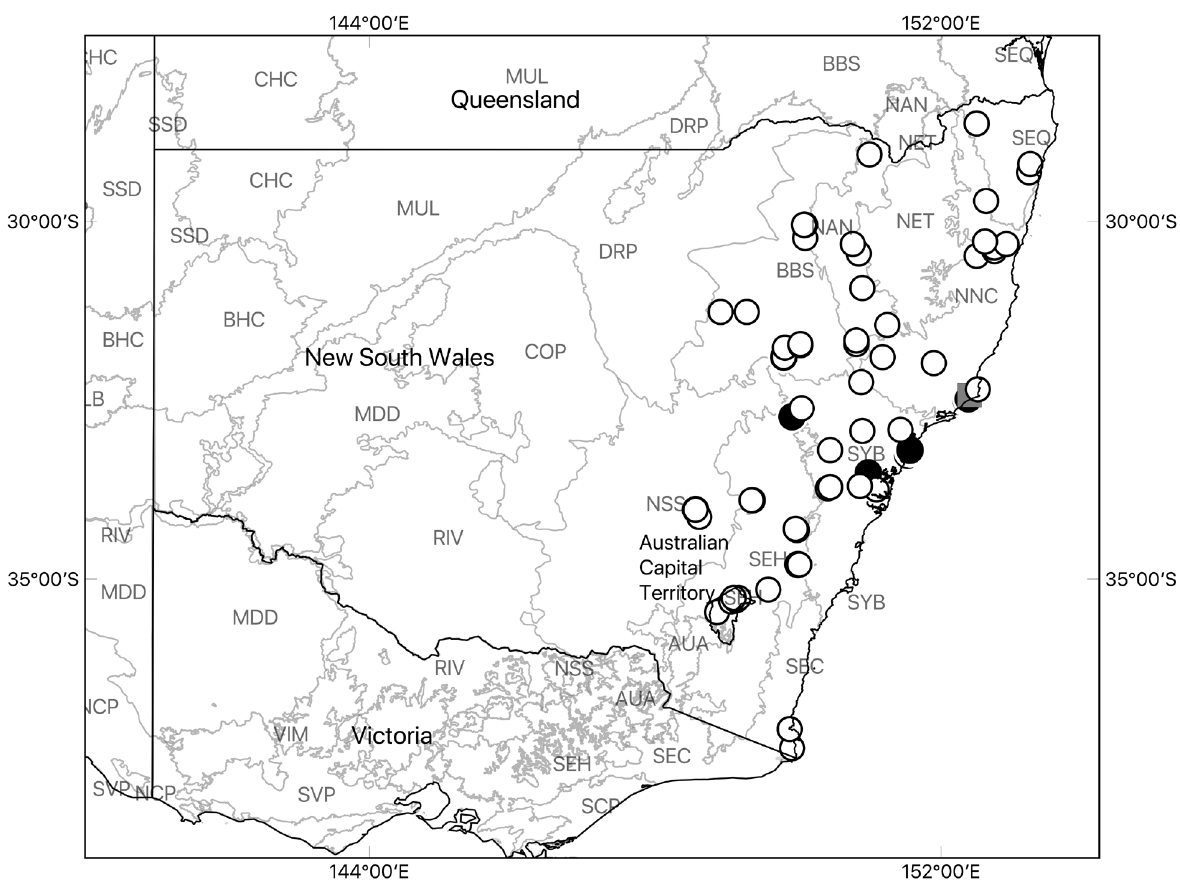
Figure 34. Distribution records of Artoria munmorah sp. n. (full circles), A. myallensis sp. n. (grey square) and A. quadrata Fra- menau, 2002 (open circles) in NSW and ACT. IBRA bioregions with spider records: AUA – Australian Alps; BBS – Brigalow Belt South; NAN – Nandewar; NET – New England Tablelands; NNC – NSW North Coast; NSS – NSW South Western Slopes; SEQ – South East Queensland; SEH – South Eastern Highlands; SEC – South East Corner; SYB – Sydney